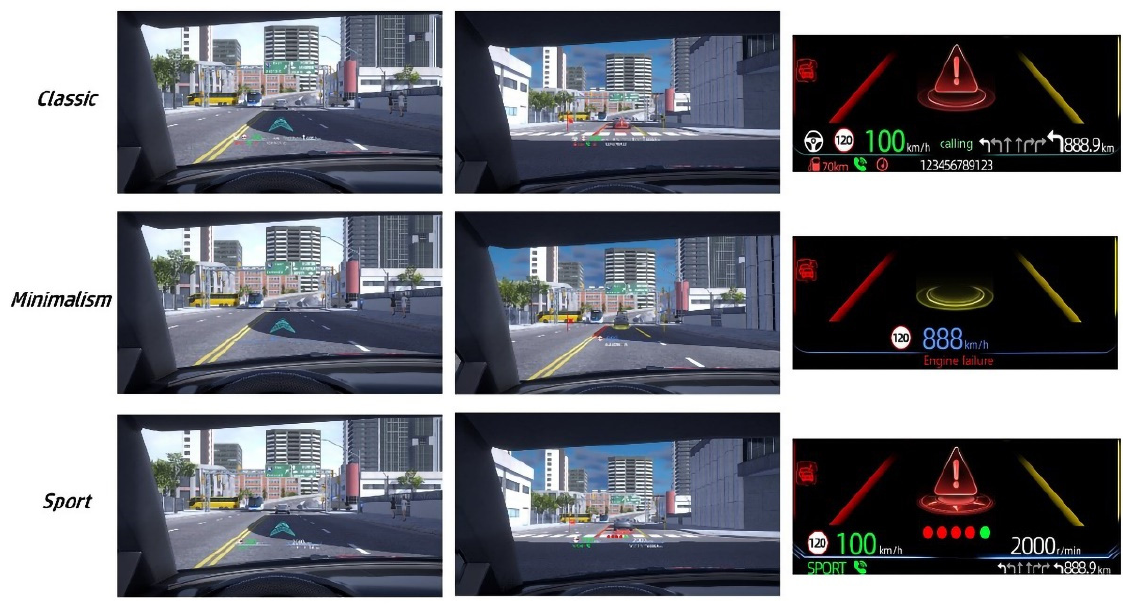
Figure 3. HUD interface design scheme 2. Scheme 2 adopts hollow navigation arrows, which enhance the integration of AR icons and the real environment and avoid visual obstructions to road conditions. Cyclic annular warning icons are designed for the WSP and FCWS. To be specific, icons in sport mode are designed to be more dynamic and powerful.